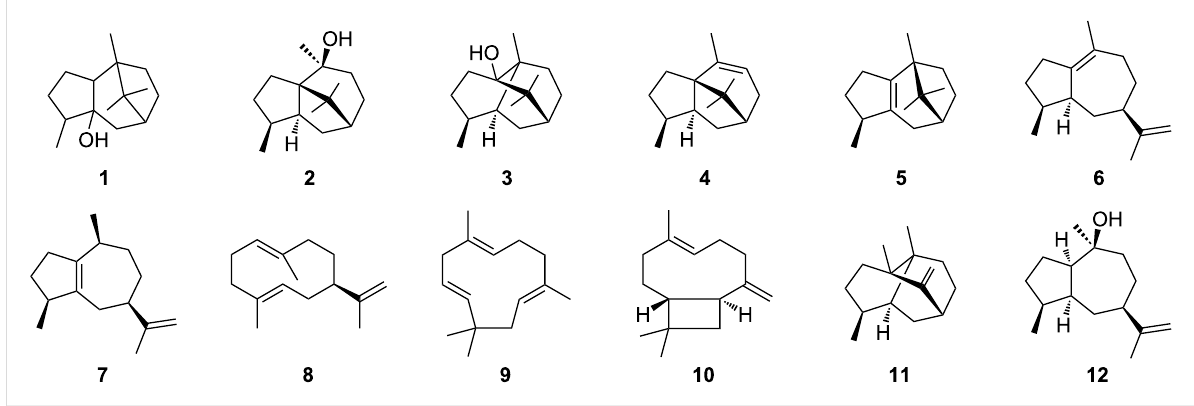
Figure 1: Initially assigned structures for patchoulol by Treibs ( 1 ) and by Büchi ( 2 ). Structures of patchoulol ( 3 ) and side products of patchoulol synthase ( 4 – 12 ).